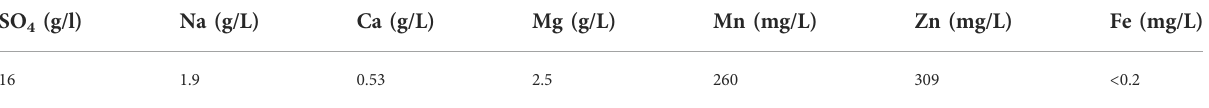
TABLE 1 The chemical composition of industrial wastewater used in this study.